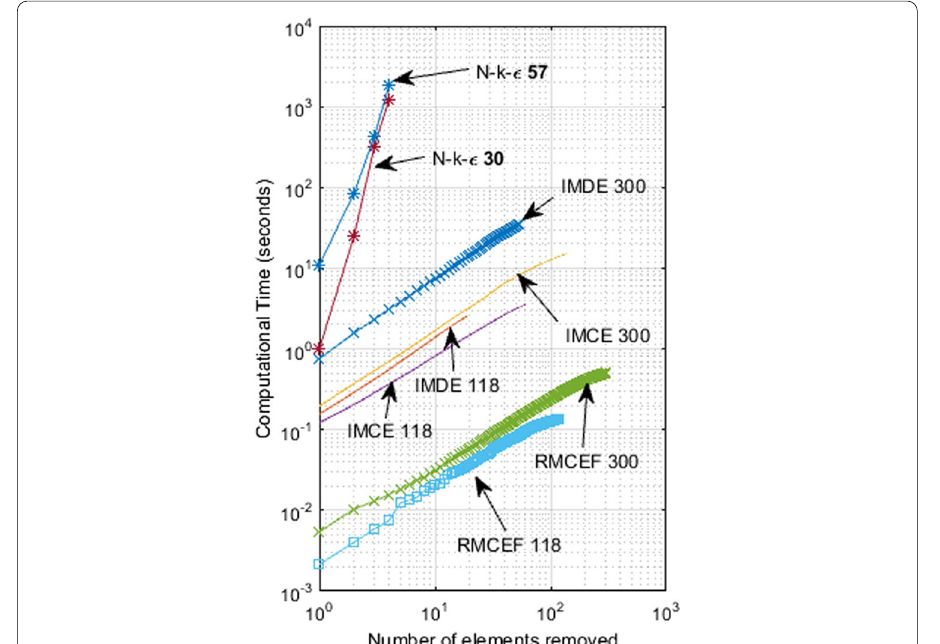
Fig. 11 Comparing the running time versus number of elements